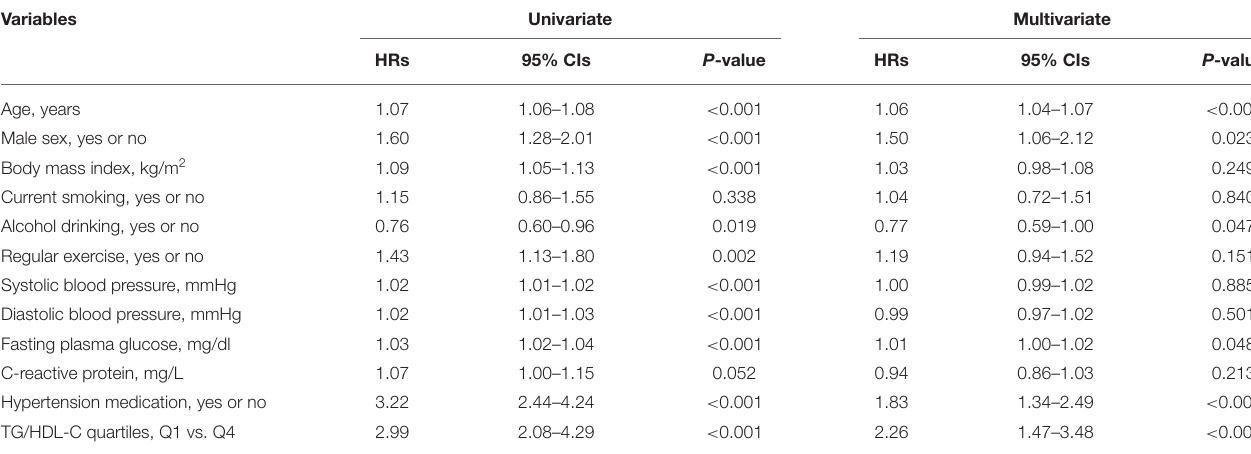
TABLE 3 | Univariate and multivariate Cox proportional-hazards regression models for incident ischemic heart disease. Variables